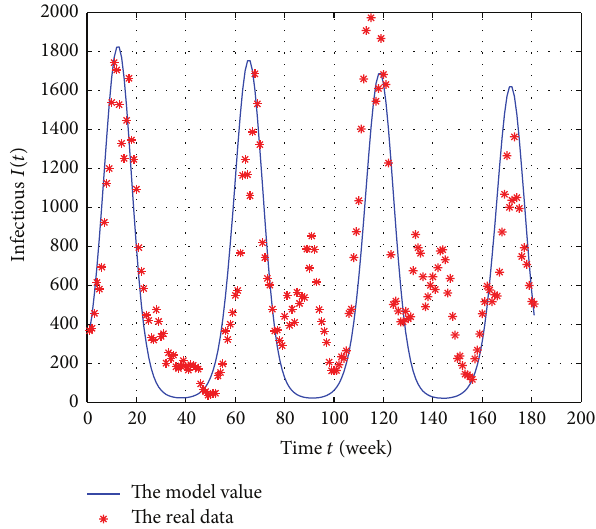
Figure 1: The solid curve represents the simulation results and the stars are the weekly data from 2010 to 2013 reported by the Wenzhou CDC.